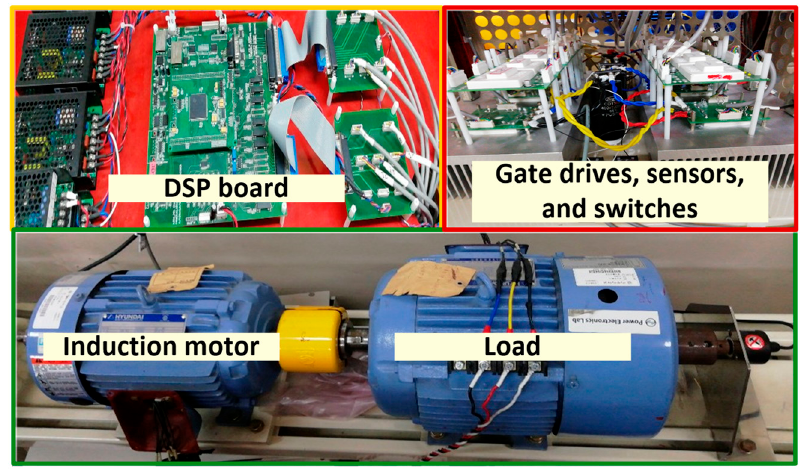
Figure 8. Experimental setup. DSP—digital signal processor. Table 3. Induction motor parameters.